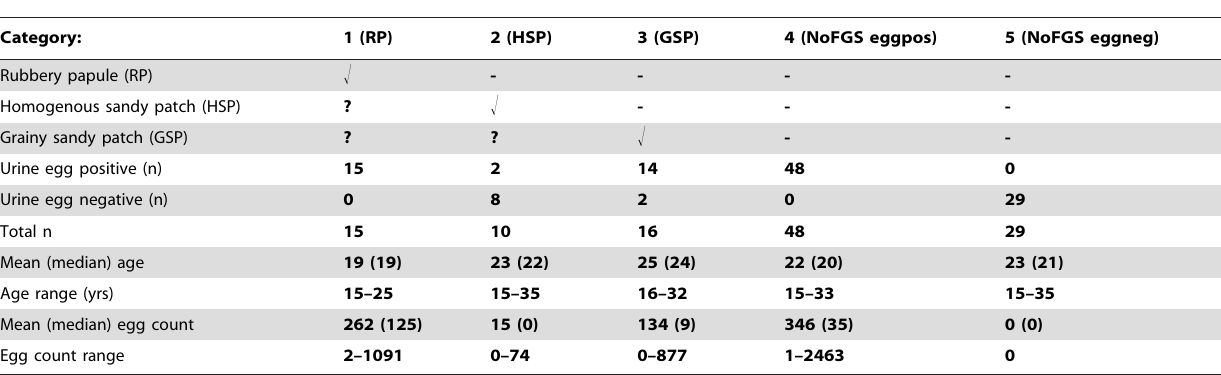
Table 1. FGS diagnostic categories used for data